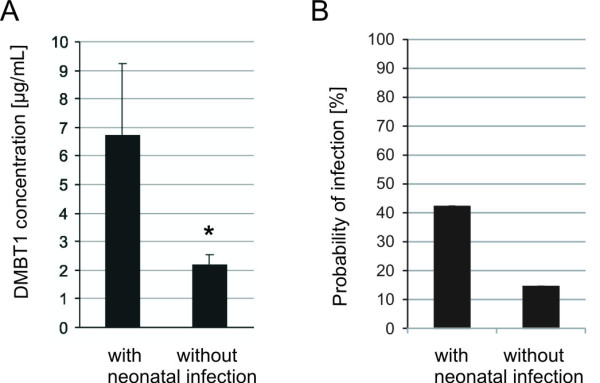
DMBT1 concentration in breast milk and neonatal infections. The DMBT1 concentration (mean ± SEM) in the breast milk from mothers of infants with neonatal infections versus infants without neonatal infection are demonstrated in A. The breast milk from mothers of neonates with infections showed significantly higher DMBT1 concentrations compared to the breast milk from mothers of neonates without infections (* P <0.05). B illustrates the calculated probability for an infection using the DMBT1 concentration-based mathematical equation for infants with versus without confirmed neonatal infection.